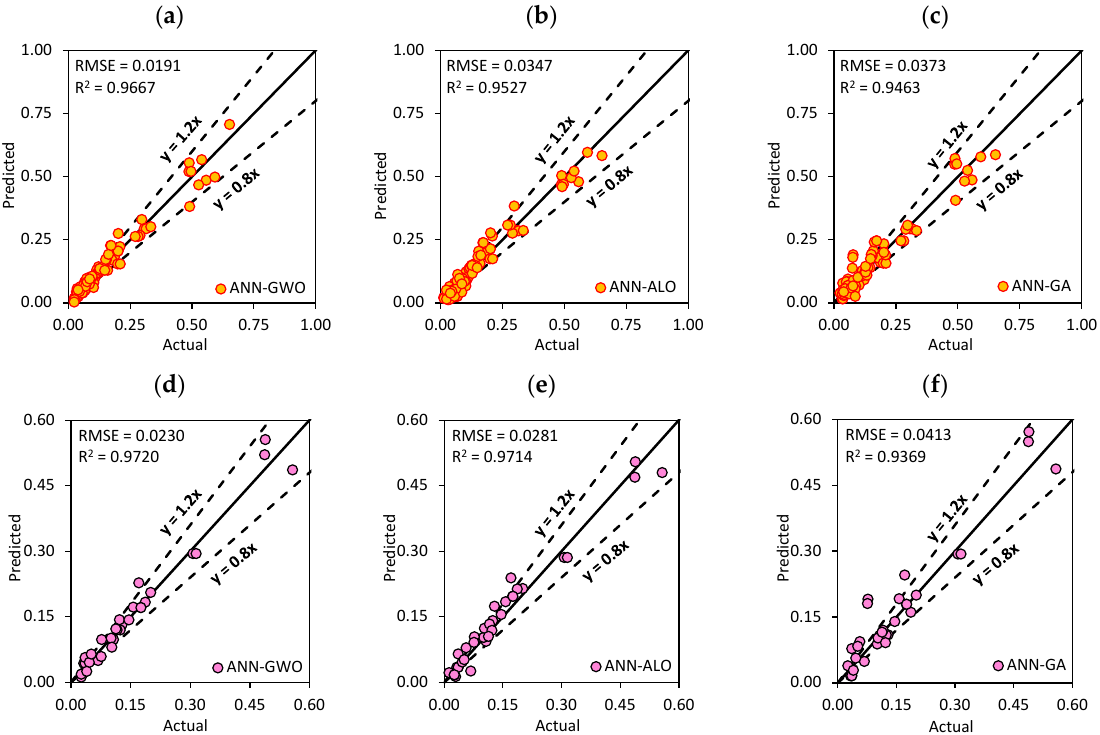
models were near 0. The score analysis indicates that the ANN-DE and ANN-ABC models were again the underachieving models for testing.